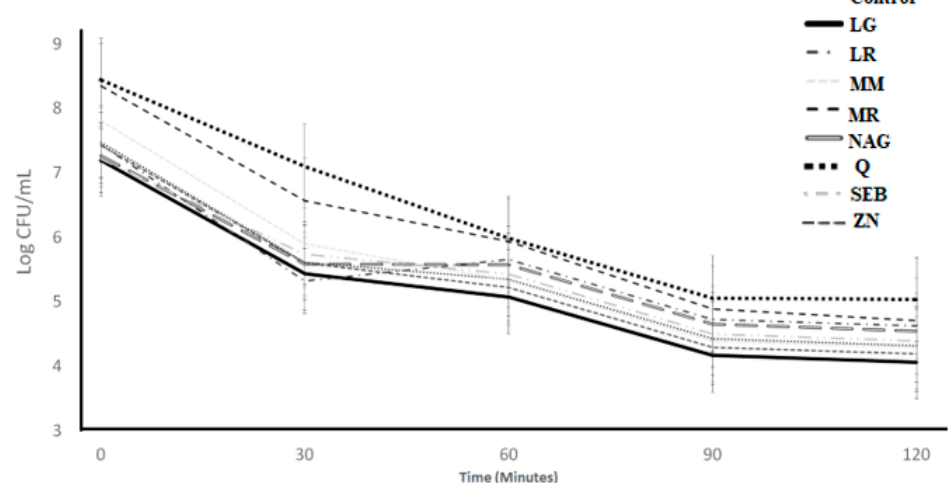
Figure 9. Log counts of Streptococcus thermophilus showing its resistance to lysozyme as in fl uenced by ingredients during an incubation time of 120 min. C = control, LG = L-glutamine (7 g/L), Q = quercetin (700 mg/L), SEB = slippery elm bark (210 mg/L), MR = marshmallow root (1340 mg/L), NAG = N-acetyl-D-glucosamine (210 mg/L), LR = licorice root (210 mg/L), MM = maitake mushrooms (42 mg/L), and ZN = zinc orotate (70 mg/L). Error bars represent SE. Lysozyme resistance of L. bulgaricus as in fl uenced by ingredients that help treat leaky gut is shown in Figure 10. The ingredient e ff ect, time e ff ect, and ingredient × time interaction e ff ect were signi fi cant ( p < 0.05). In 30, 60, 90, and 120 min, quercetin, licorice root, slippery elm bark, and marshmallow root samples had signi fi cantly ( p < 0.05) higher log counts than the control samples (Table 6).